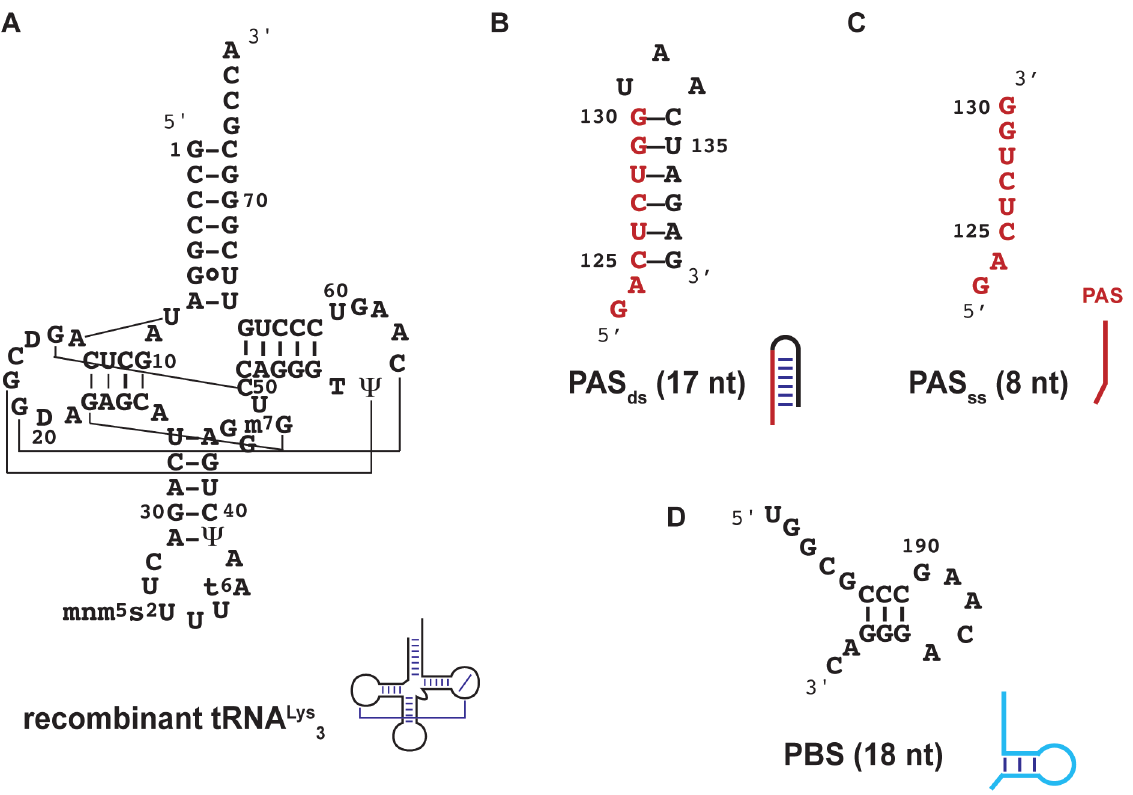
Figure 2. Secondary structures of RNA used in this study. A) the recombinant tRNA Lys 3 expressed in E. coli , B) the hairpin encompassing PAS sequence, the double-stranded PAS (PAS ds ) with the numbering of nucleotides in the HXB2 isolate, C) the single-stranded PAS sequence (PAS ss ) and D) the PBS. A cartoon symbolizing the secondary structure of these RNAs is drawn next their names.